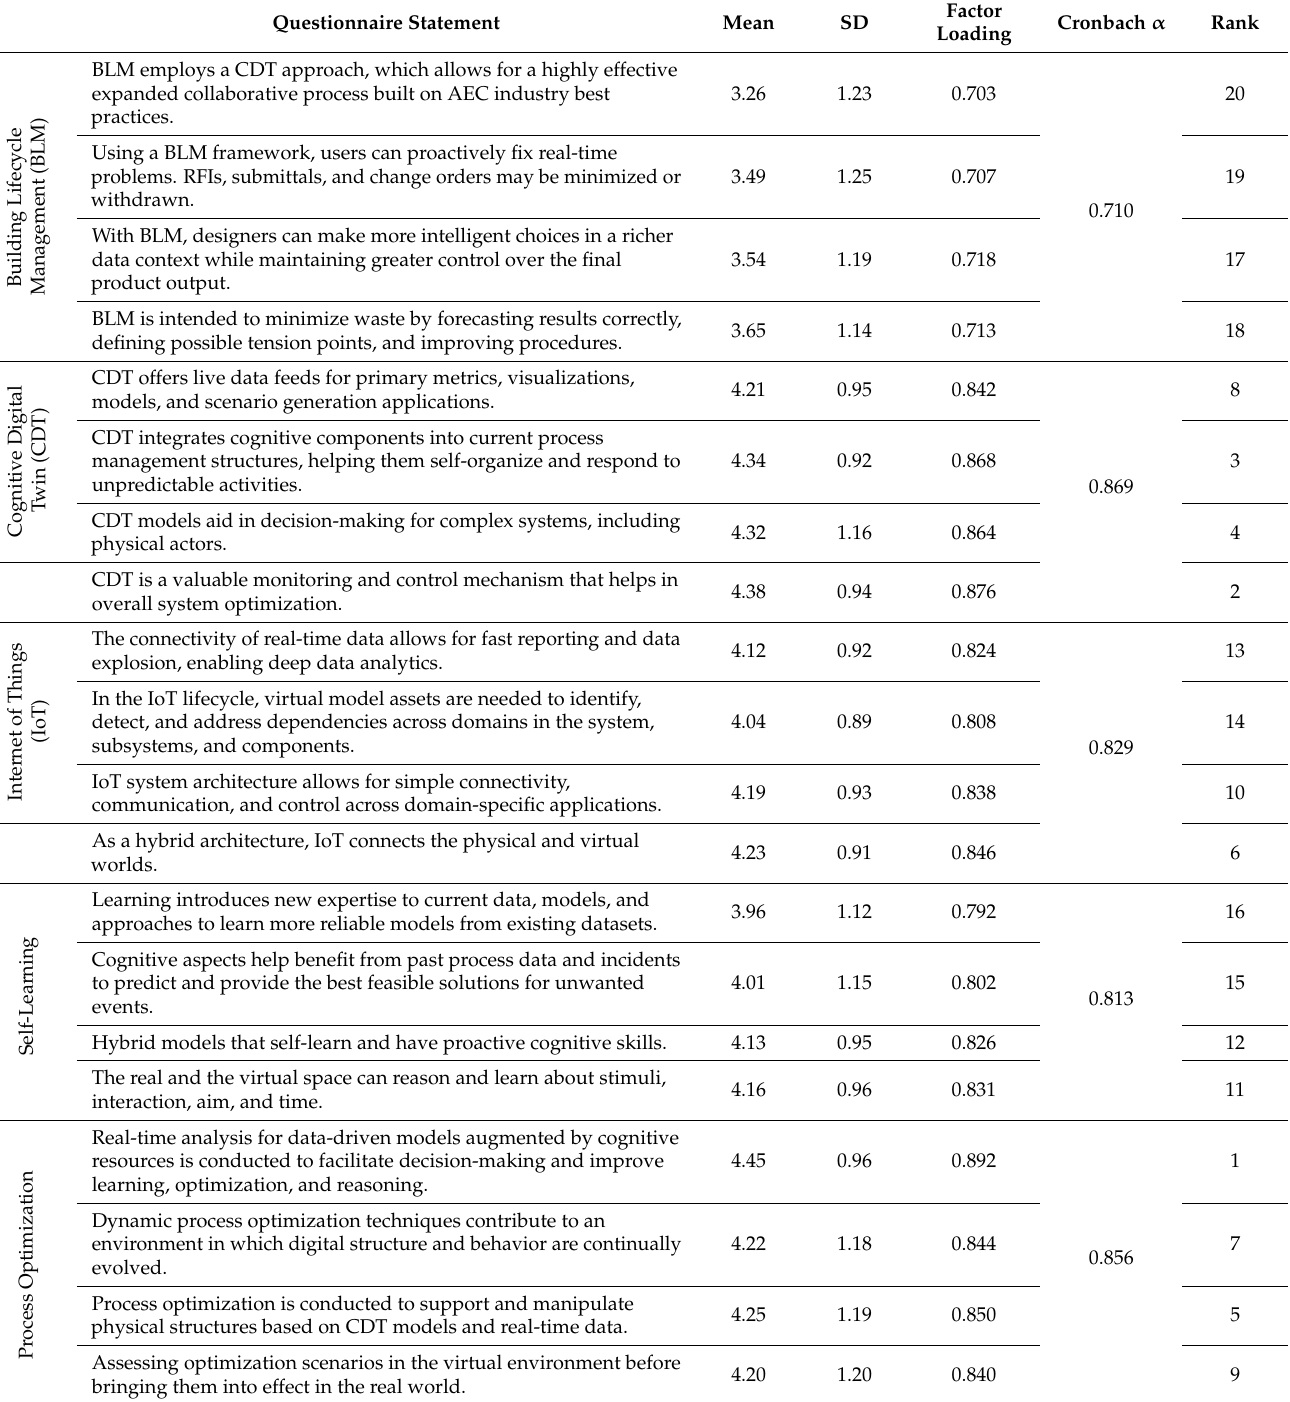
Table 4. Descriptive statistics, factor analysis and reliability